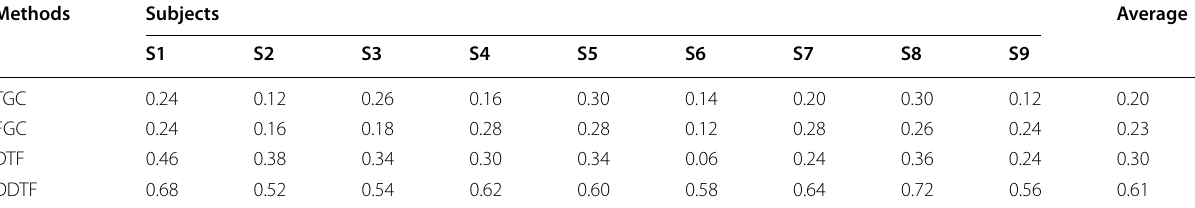
Table 4 Comparison of Kappa coefficients with GC-based BFN methods on Dataset B Methods